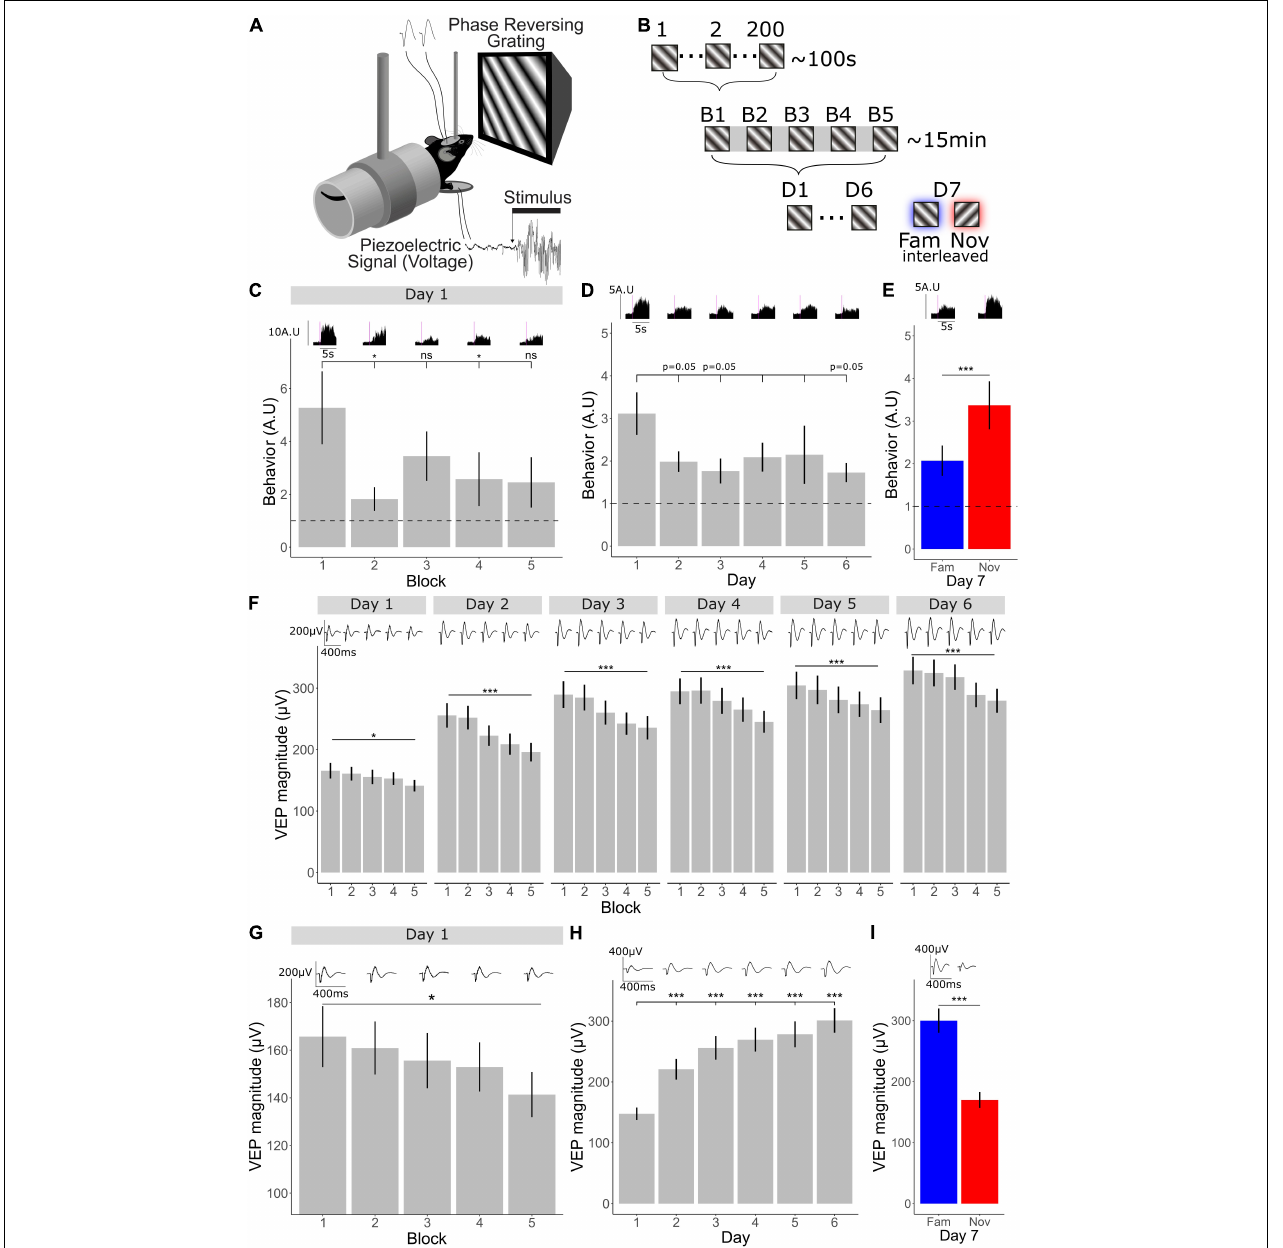
FIGURE 1 | V1 plasticity accompanying long- and short-term habituation occurs in opposing directions. (A) Schematic of recording set-up. Mice viewed phase reversing gratings while layer 4 local-field potentials were recorded through implanted tungsten electrodes and movement was recorded through a piezo-electrical device. (B) 1 through 200 individual phase reversals were shown lasting approximately 100 s (1 block). Five blocks were shown lasting approximately 15 min within one session. One session of 5 blocks was shown for 6 days. On the 7th day, the familiar orientation (previously viewed) and a novel orientation were shown pseudo-randomly interleaved. (C) Comparison of behavior across blocks ( n = 30). Friedman test χ 2 (4) = 13.8, p = 0.008. Post-hoc analysis of individual comparisons of blocks 1–2: p = 0.02, blocks 1–3: p = 0.7, blocks 1–4: p = 0.04, blocks 1–5: p = 0.5. FDR correction for multiple comparisons. (D) Behavioral change over days 1–6 ( n = 30). Freidman test χ 2 (5) = 6.55, p = 0.3. Post-hoc analysis of individual comparisons of days 1–2: p = 0.05, days 1–3: p = 0.05, days 1–4: p = 0.2, days 1–5: p = 0.09, days 1–6: p = 0.05. FDR correction for multiple comparisons. (E) Behavioral response to familiar and novel ( n = 30).